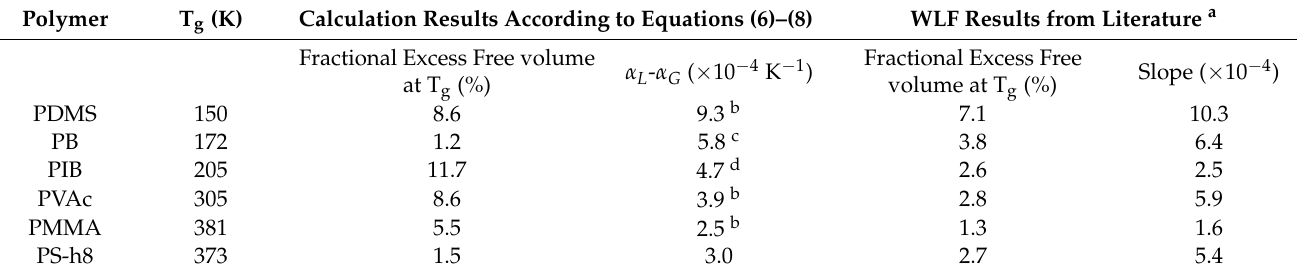
Table 1. The temperature-dependent fractional excess free volume when it is close to glass formation. Calculation results according to both our model (Equations (6)–(8)) and WLF equation in the literature (if α G could not be found in the literature, only α L was